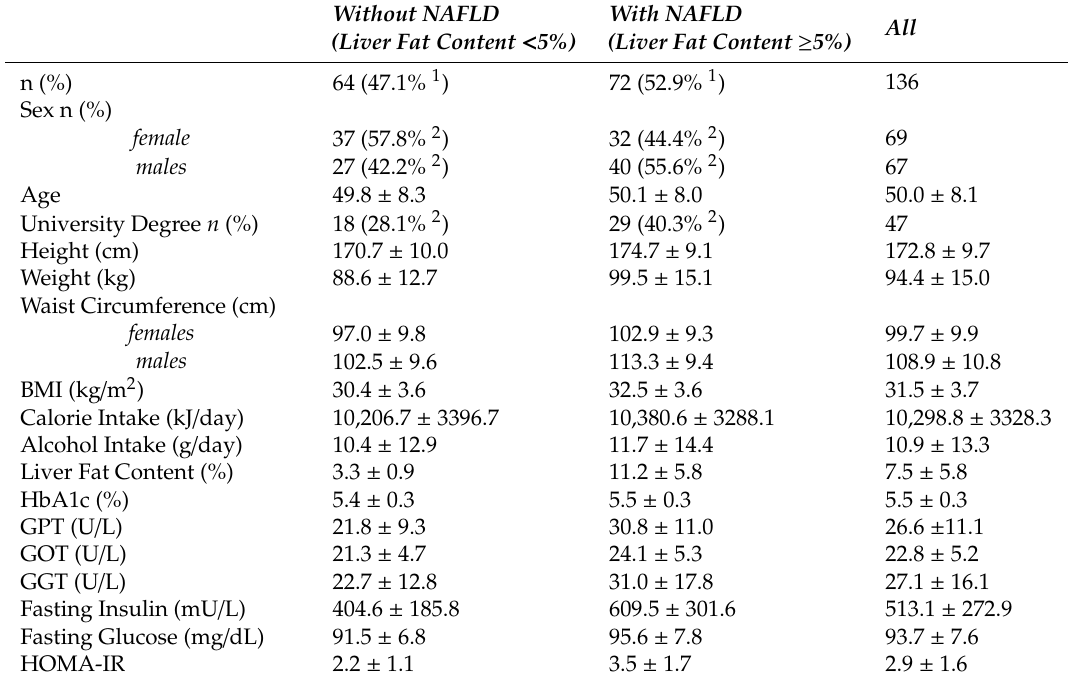
Table 1. Characteristics of the study population ( n =